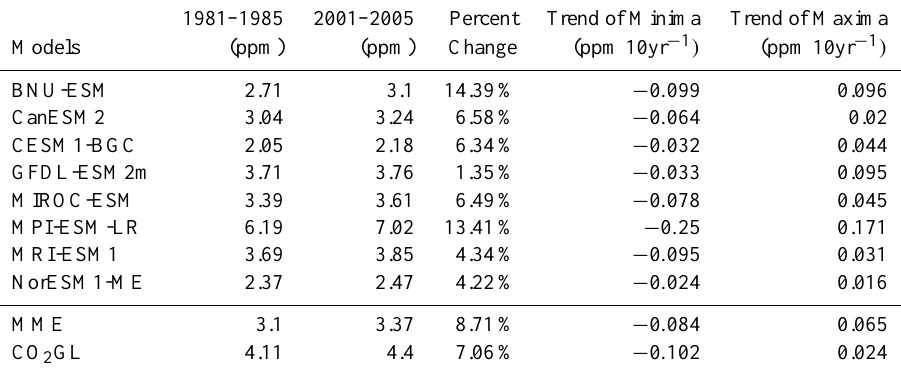
∗ The multi-model ensemble (MME) here is a simple average over the nine models in the table. The values are slightly larger than given in text because of averaging method (in the main text, multi-model averaging of detrended variables are done first, then their amplitude are computed and mean amplitude changes are derived). Table 3. Amplitude increase (ppm) and trends of maxima/minima of surface CO 2 from eight models, their multi-model ensemble (MME), and ESRL’s Global mean CO 2 (CO 2